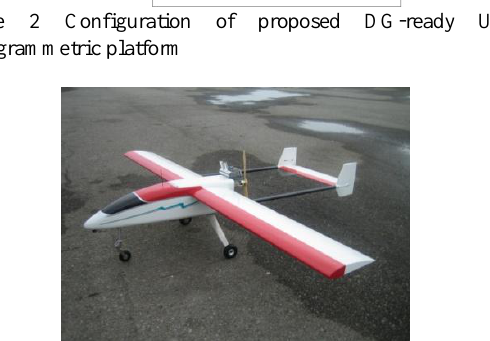
Figure 3 Photograph of proposed UAV platform